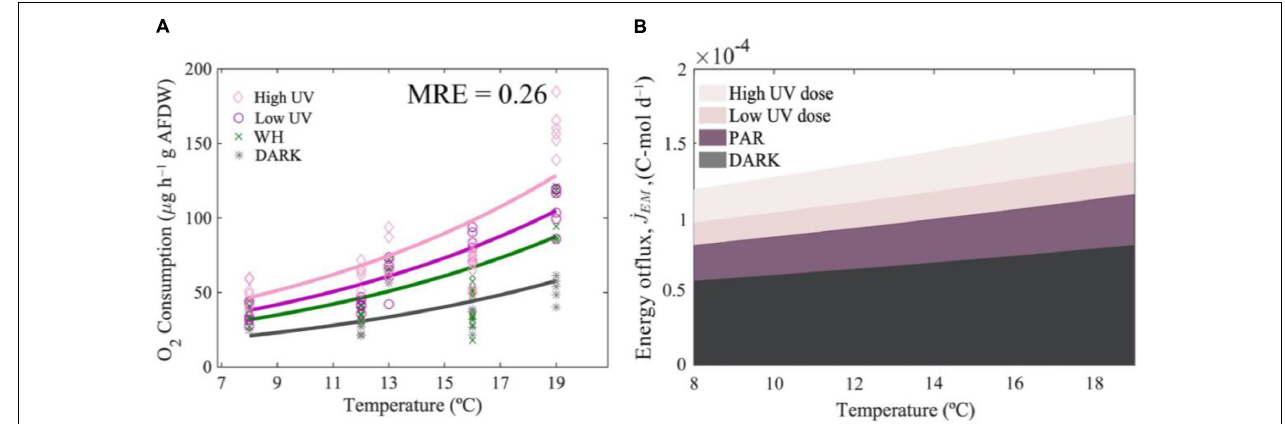
FIGURE 4 | Metabolic responses to light and temperature. Predicted changes in respiration rates of Nyctiphanes australis with light and temperature (A) . Effect of temperature on the total outflux of energy from the reserves to cover somatic maintenance at different levels of UVR and at different light condition (B) .